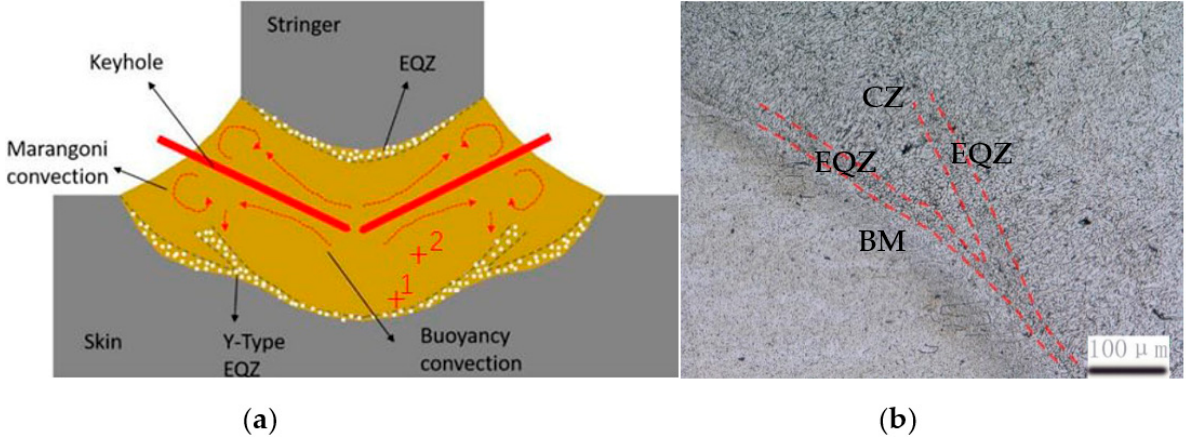
Figure 3. ( a ) Microstructure of the cross section; ( b ) Y-type EQZ.